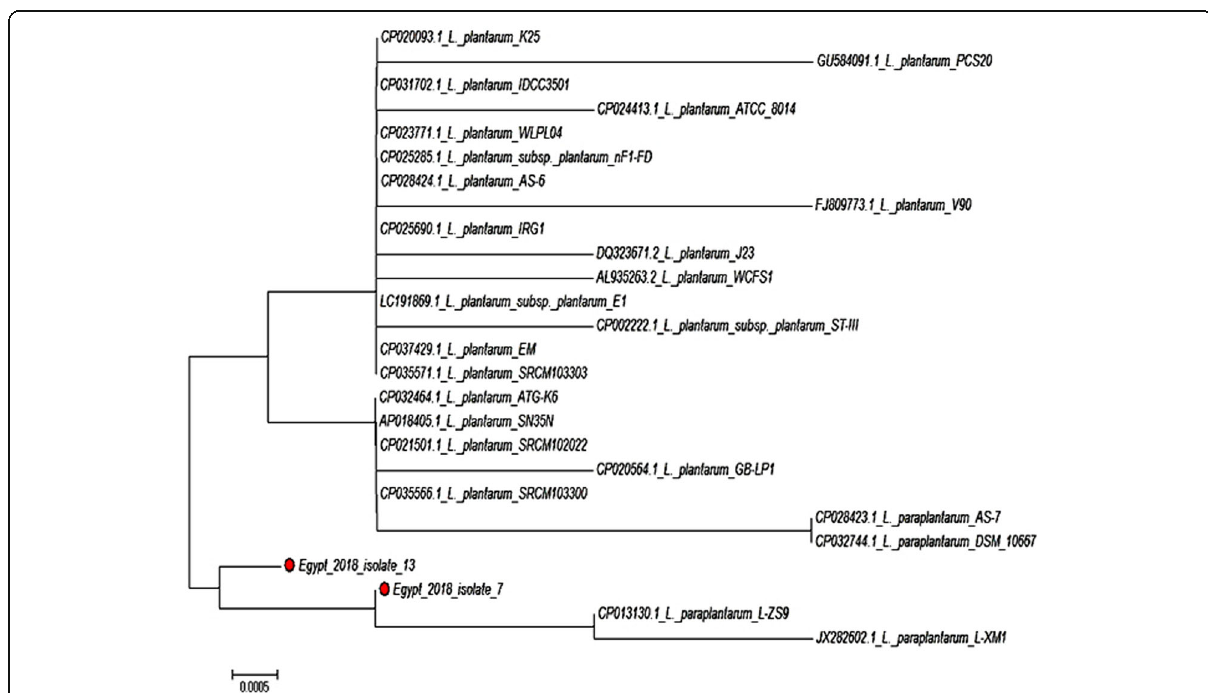
Fig. 2 Phylogenetic tree based upon the neighbor-joining of DNA gene sequences of Pln EF gene for Lb. plantarum strain isolate no. 13